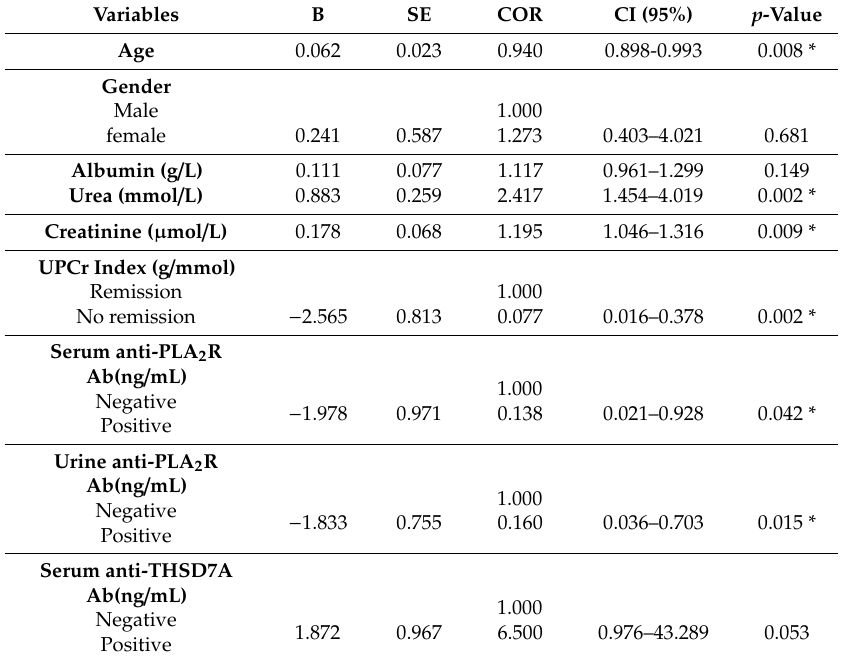
Table 4. Simple logistic regression for the prognostic outcome of primary MGN using eGFR (CKD ≥ 3). Variables